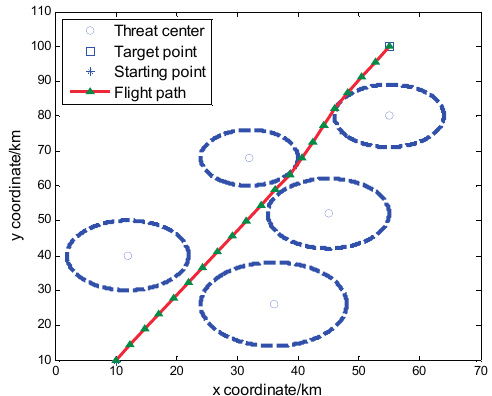
Figure 6. Result of the first instance for D = 20.